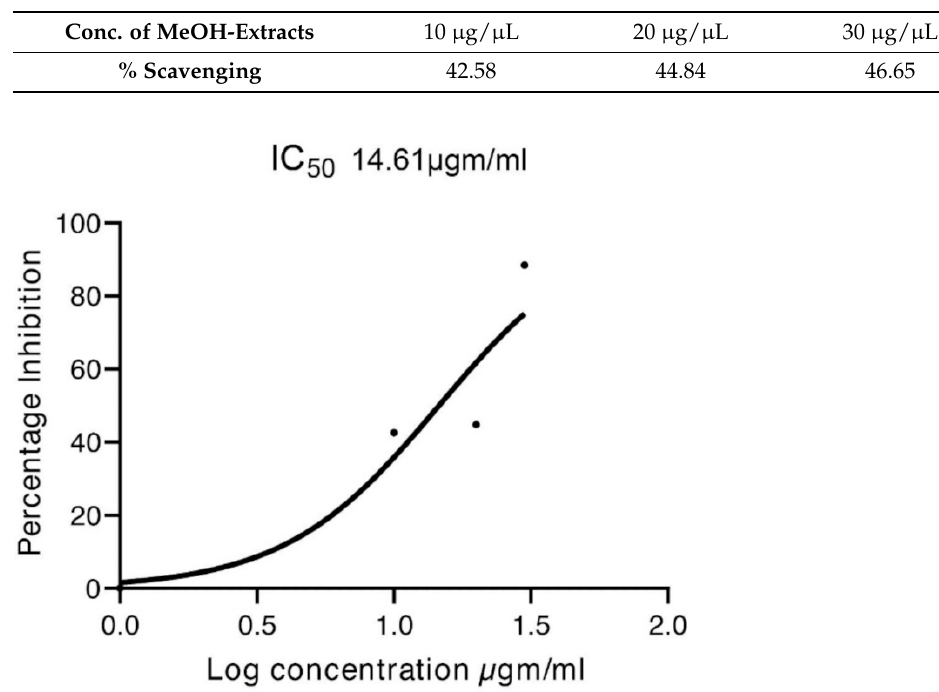
Table 1. Antioxidant activity of the methanolic bark extracts of Z. armatum .